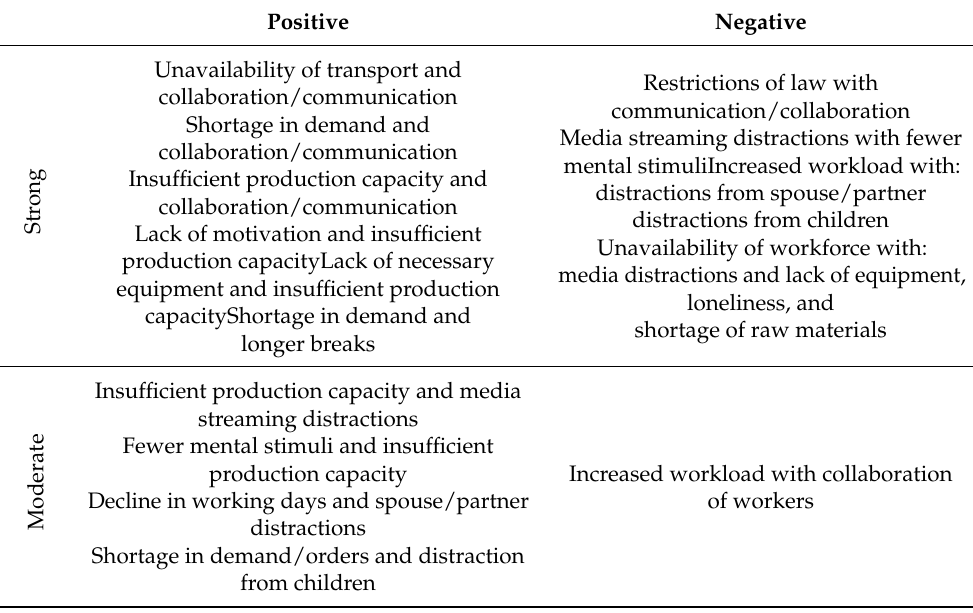
Table 4. Correlations among operational activities and top struggles of remote